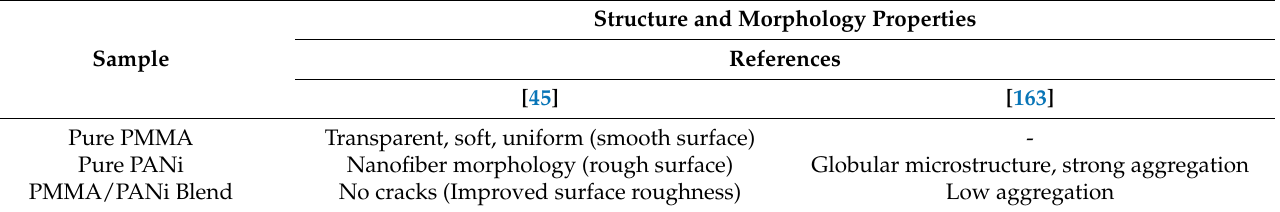
Table 11. Comparison of structure and morphology properties between pure PMMA, pure PANi, and PMMA/PANi blend. Structure and Morphology Sample